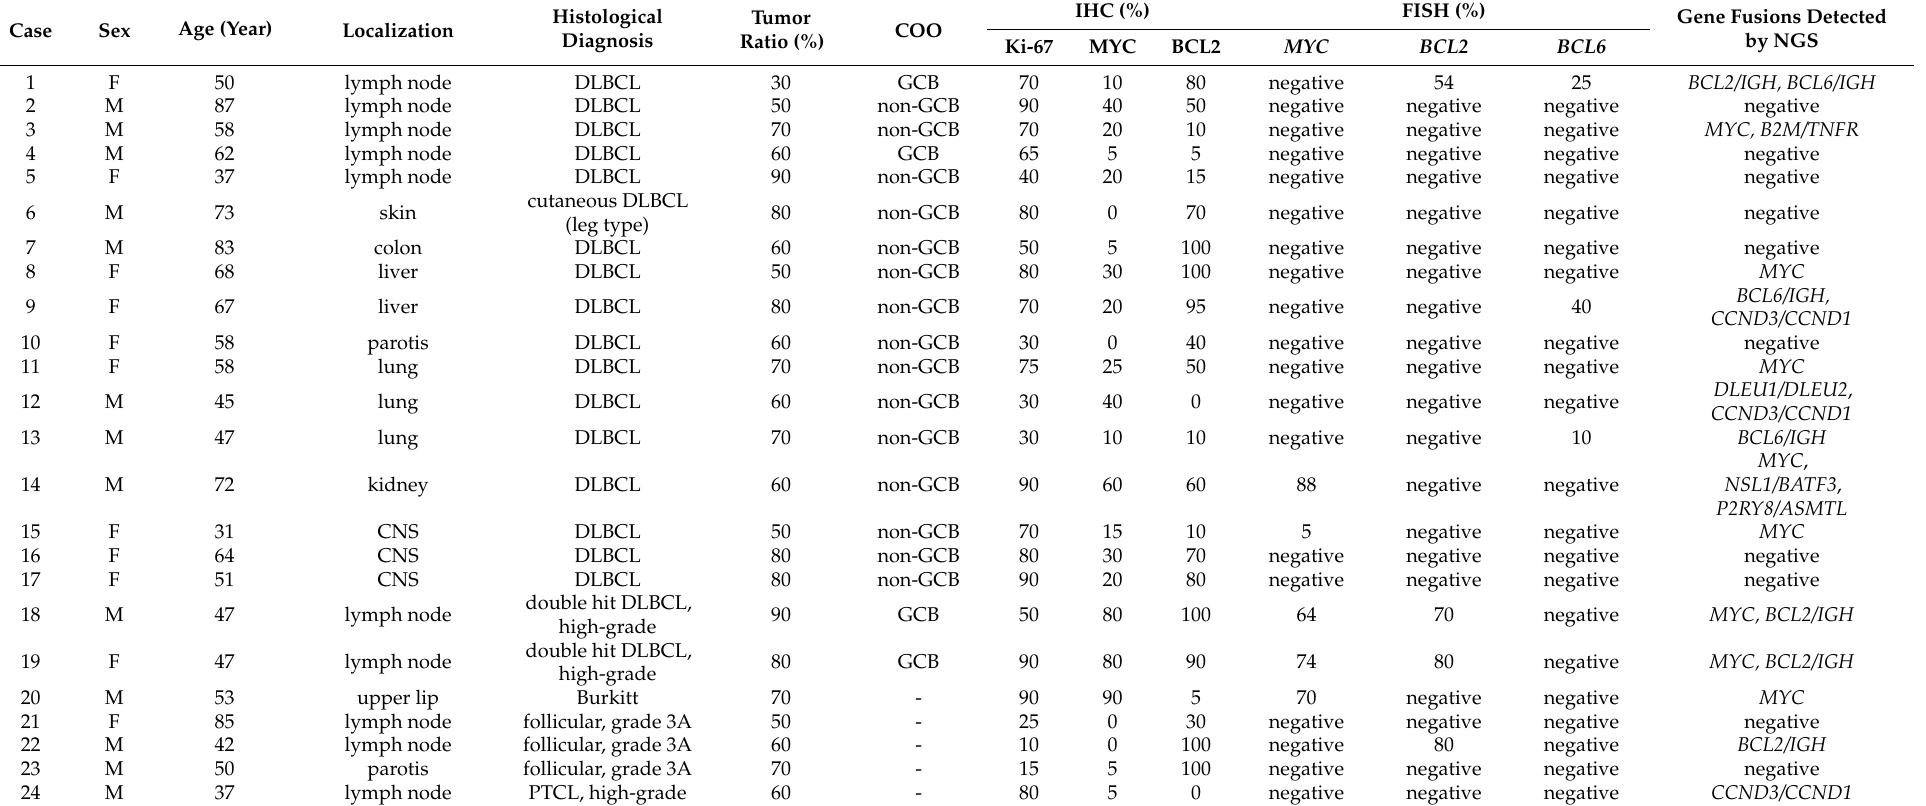
Table 1. Histopathological, immunohistochemical (IHC), fluorescence in situ hybridization (FISH), and NGS gene fusion results of aggressive lymphoma patients. CNS: central nervous system, DLBCL: diffuse large B-cell lymphoma, PTCL: peripheral T-cell lymphoma, COO: cell of origin, GCB: germinal center B